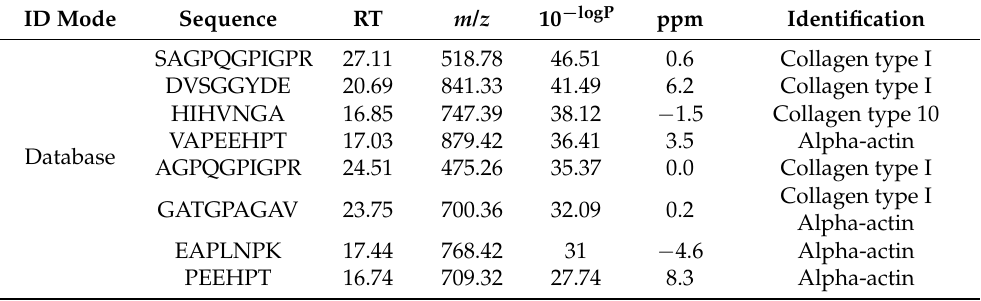
Figure 6. Mass signal 3D-map of the FE subfraction issued from the RP-HPLC separation of the FBPH intestinal digest’s SEC-F2 fraction. Peptide map showing the repartition of all peptides detected by RP-UPLC-MS/MS analysis according to their retention time during chromatography, their mass to charge ratio ( m / z ) and their intensity. Grey signals represent all ions detected, blue squares represent identified peptides by database confrontation (false discovery rate (FDR) < 1%) and orange squares represent peptides sequenced by de novo mode (ALC score > 80%). Table 1. List of the 20 peptides selected for chemical synthesis, following their identification by database confrontation or de novo sequencing. Peptides were listed according to their RP-UPLC- MS/MS characteristics (retention time (RT), mass to charge ratio ( m / z ) and their identification score displayed (i) by the average local confidence (ALC) score for the de novo sequencing, (ii) by the − 10 logP score for database confrontation with the mass error (in ppm) for both identification modes (ID). nd: when the identification of the parent protein was not